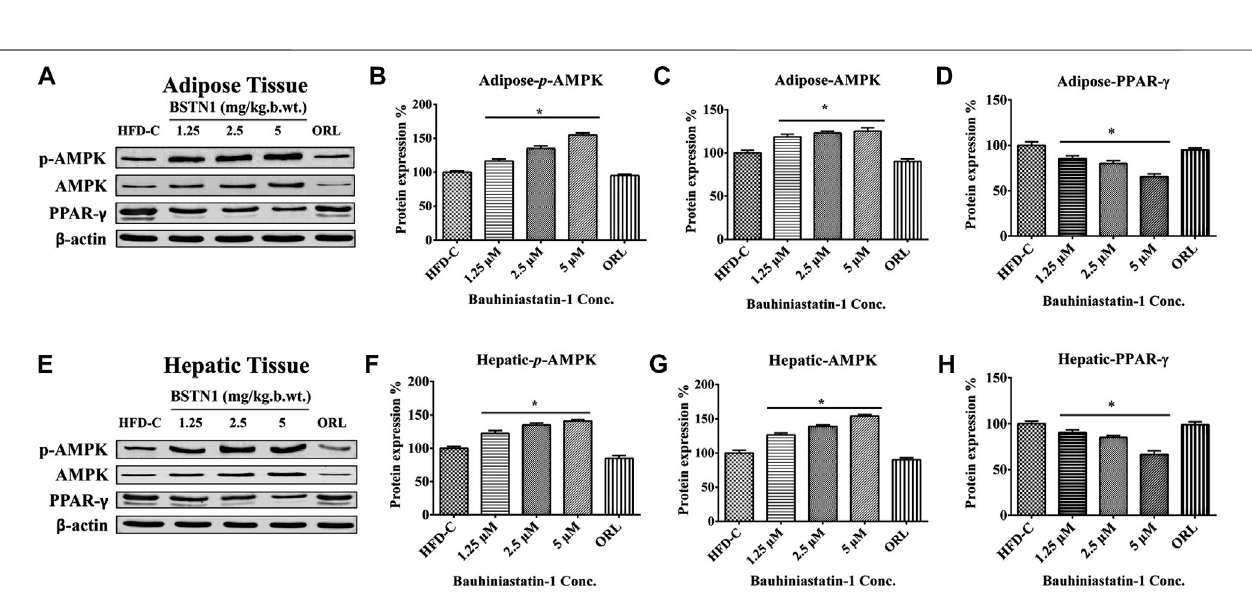
FIGURE 4 | Western blot analysis: Protein expression of control and treated rats in (A) adipose tissue and (E) liver tissue. β -actin is used as a housekeeping gene. Histograms showing quanti fi cation of expressed proteins: (B) Adipose- p -AMPK (C) adipose-AMPK (D) adipose-PPAR- γ , (F) Hepatic- p -AMPK (G) Hepatic-AMPK and (H) Hepatic-PPAR- γ . Histograms represent mean ± SD, n (cid:2) 6. * indicates signi fi cant difference ( p < 0.01) between HFD control and treated groups. AMPK, AMP- activated protein kinase and PPAR- γ , peroxisome proliferator-activated receptor- γ .